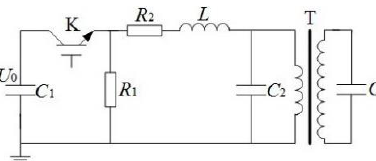
Figure 1. Circuit diagram of the principle of generating switching impulse (SI). C 1 : Main charging capacitor; C 2 : wave-modulating capacitor; K: power electronic switch (insulated gate bipolar transistor (IGBT)); R 1 : wave-tail resistor; R 2 : wave-head resistor; L : wave-modulating inductor; T: transformer; and C 3 : load capacitor.